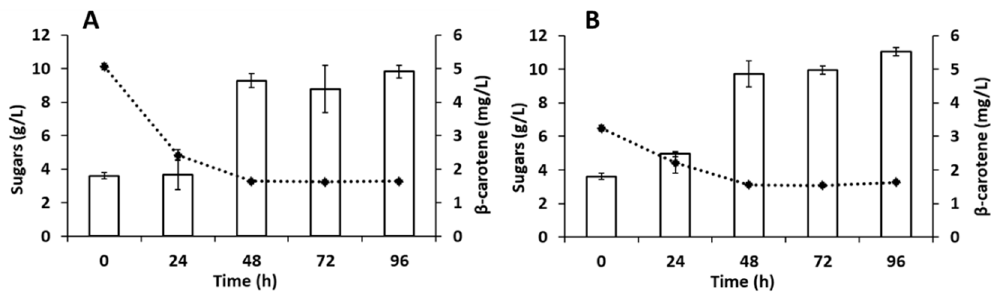
Figure 4. R. toruloides growth with 9% ( w / v ) Camelina meal hydrolysed with 0.56% w / w Camelina meal of NS22119 as growth medium in an SSF + presaccharification (panel A ) and SSF (panel B ) process. Sugar consumption (dotted line), and carotenoids production (white bars). OD or CDW values not available due to intrinsic turbidity of the medium in the presence of WIS. Values are the means of three independent experiments.